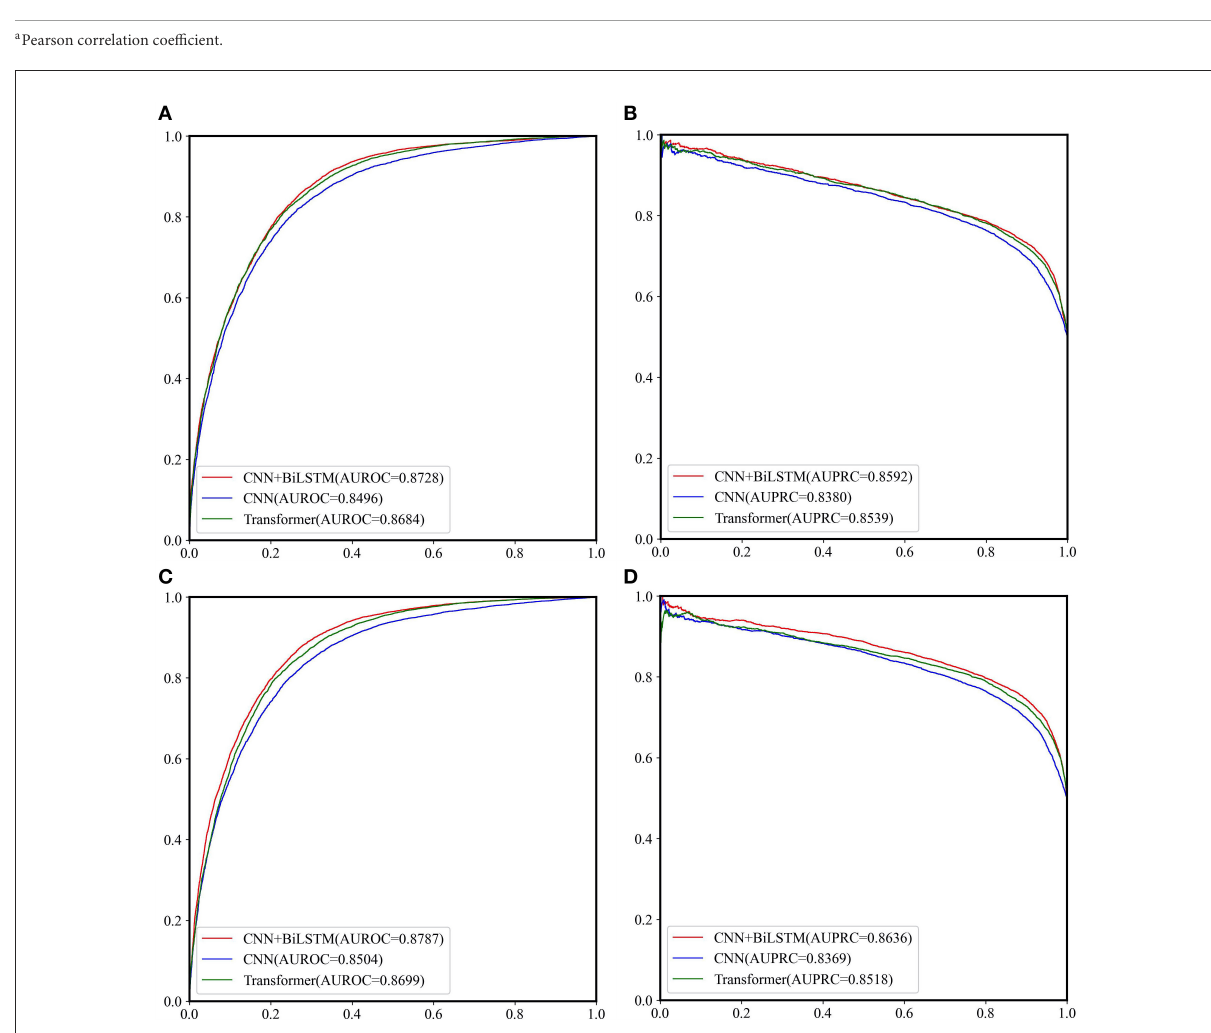
FIGURE3 The ROC curves and PRC curves based on the cross-validation results of the three network frameworks on GAC_train and AAC_train. (A) ROC curves for GAC_train; (B) PRC curves for GAC_train; (C) ROC curves for AAC_train; (D) PRC curves for AAC_train.